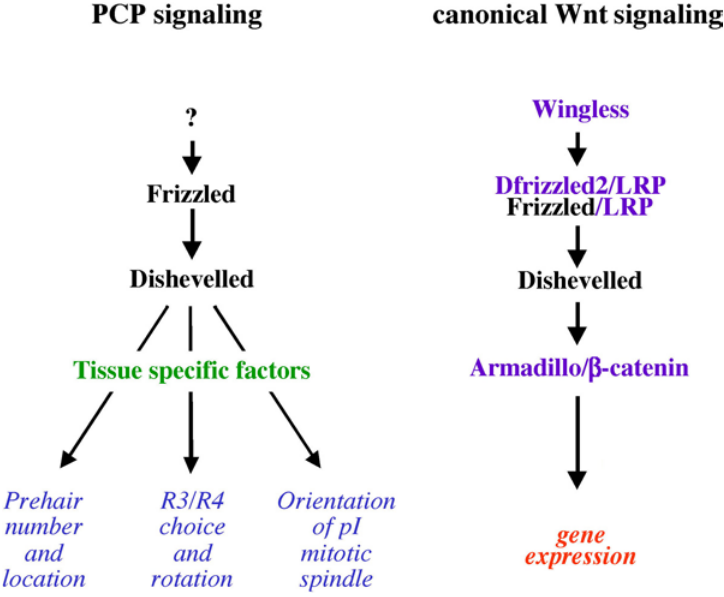
FIGURE 2 . A simplified schematic diagram of the PCP and Wg (canonical Wnt) signaling pathways. ( Left ) In PCP signaling, Fz likely serves as a receptor for an unknown ligand and acts upstream of the signal transducer, Dsh. In turn, Dsh acts upstream of tissue-specific factors to effect polarity in the various tissues. ( Right ) For comparison, a simplified schematic of the Wg/Wnt signaling pathway is shown. Fz and Dsh function in both pathways. Remarkably, part of the PCP pathway bears close resemblance to the canonical pathway mediating inductive developmental signaling by members of the Wnt family, including Drosophila Wingless (Wg, a Wnt-1 ortholog)[101,102,103]. Indeed, Dsh, Fz, and the Fz homologue, DFrizzled2 (DFz2)[104,105,106] are also known to transduce the Wingless signal. However, the downstream components are distinct. The Drosophila gene names are shown, though the pathway is